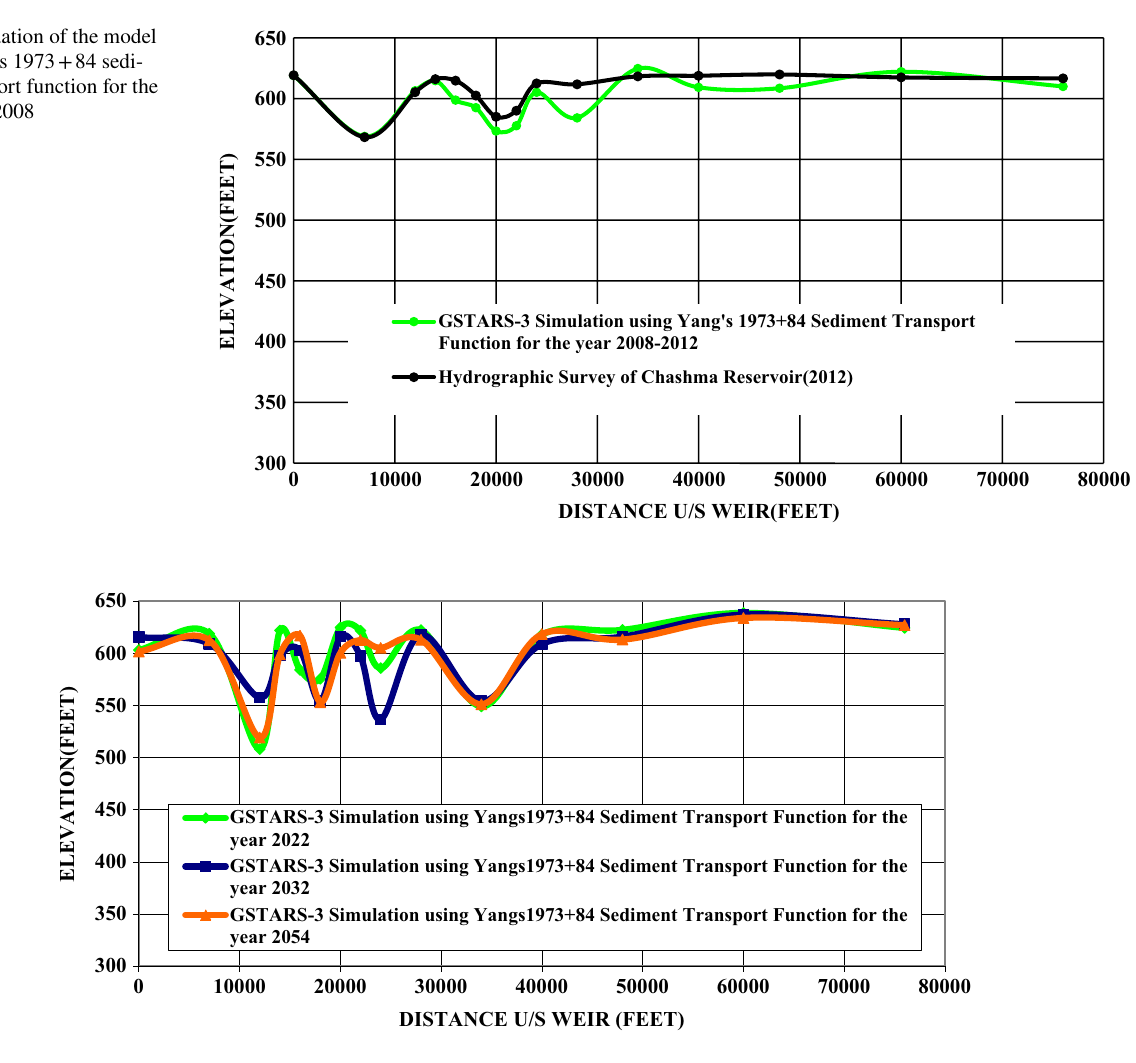
Fig. 5 Validation of the model using Yang’s 1973 + 84 sedi- ment transport function for the